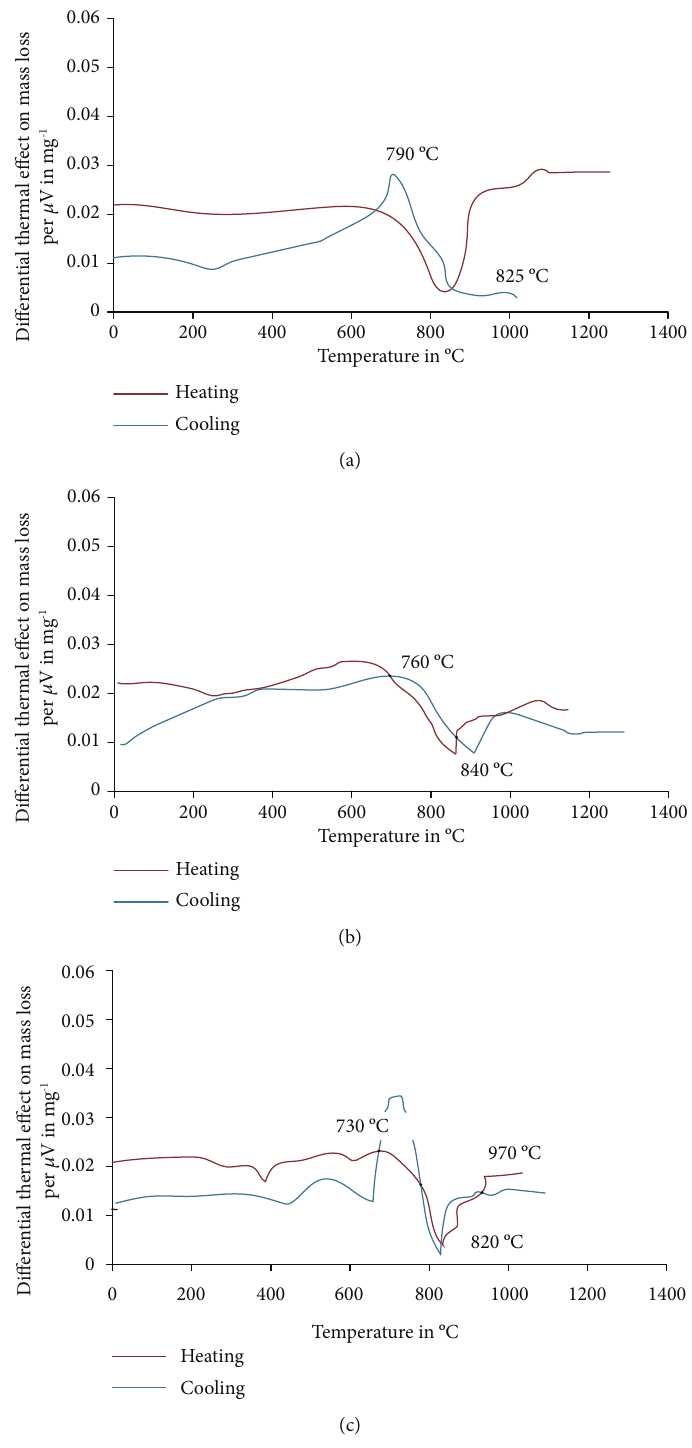
Figure 2: Di ff erential thermal e ff ect on mass loss of silver matrix hybrid nanocomposite. (a) Ag/0wt% Al O /0 wt% SiC Al 2 3np